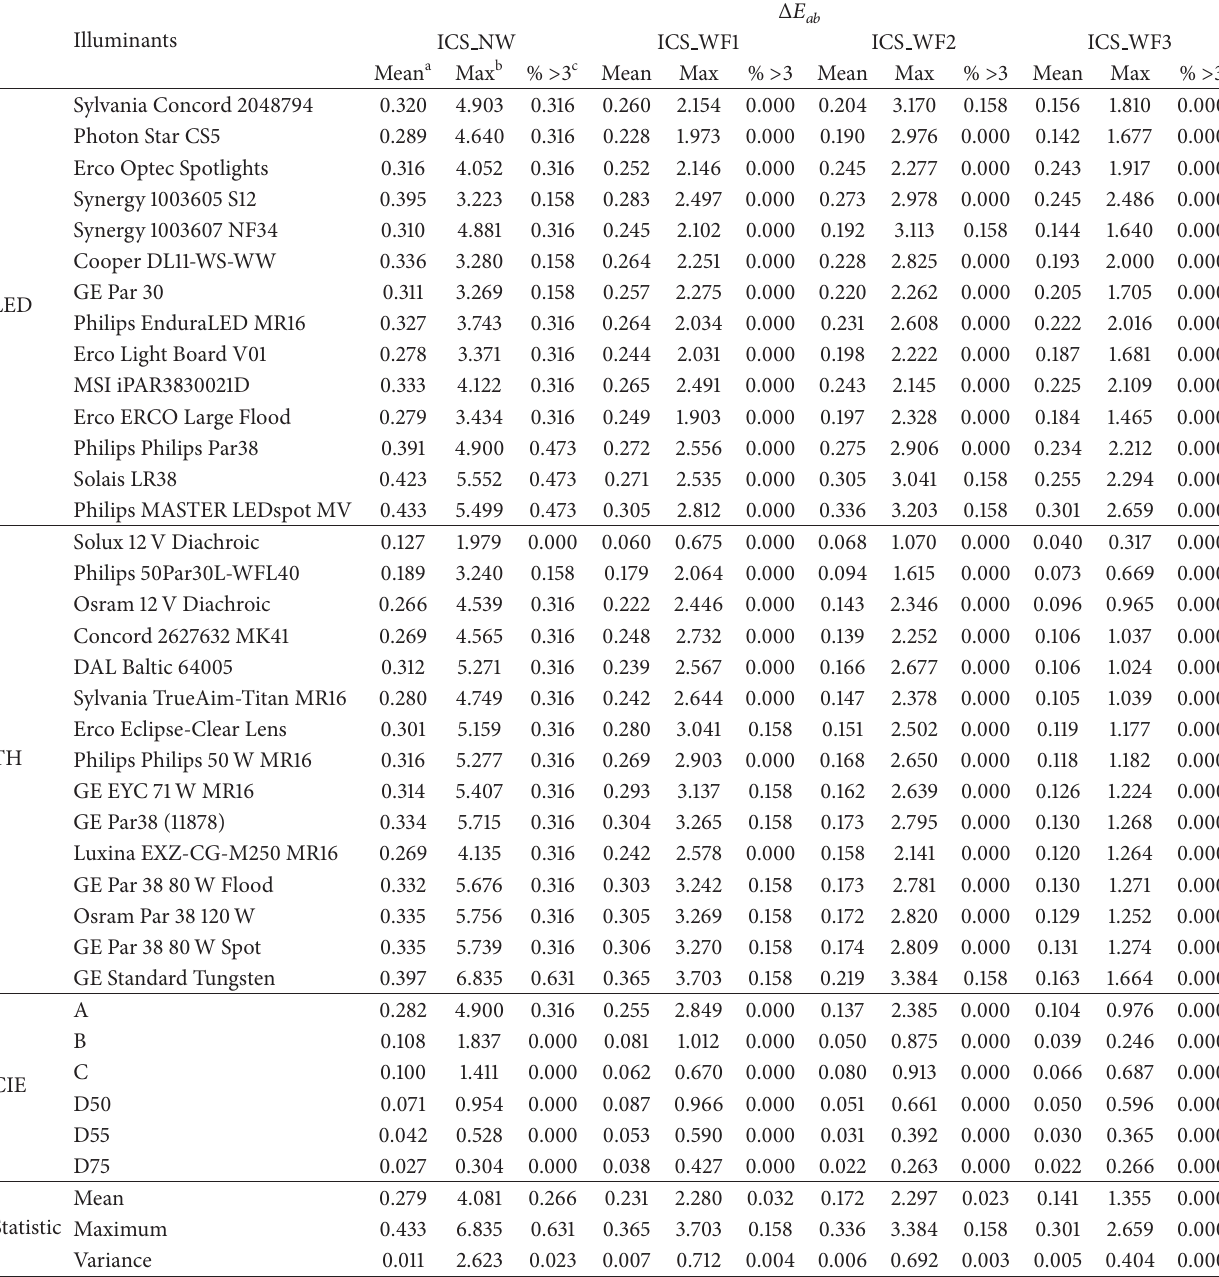
Table 1: Colorimetric representing accuracy comparison of the four ICSs with odd and even chips of Munsell as training and testing sample, respectively.